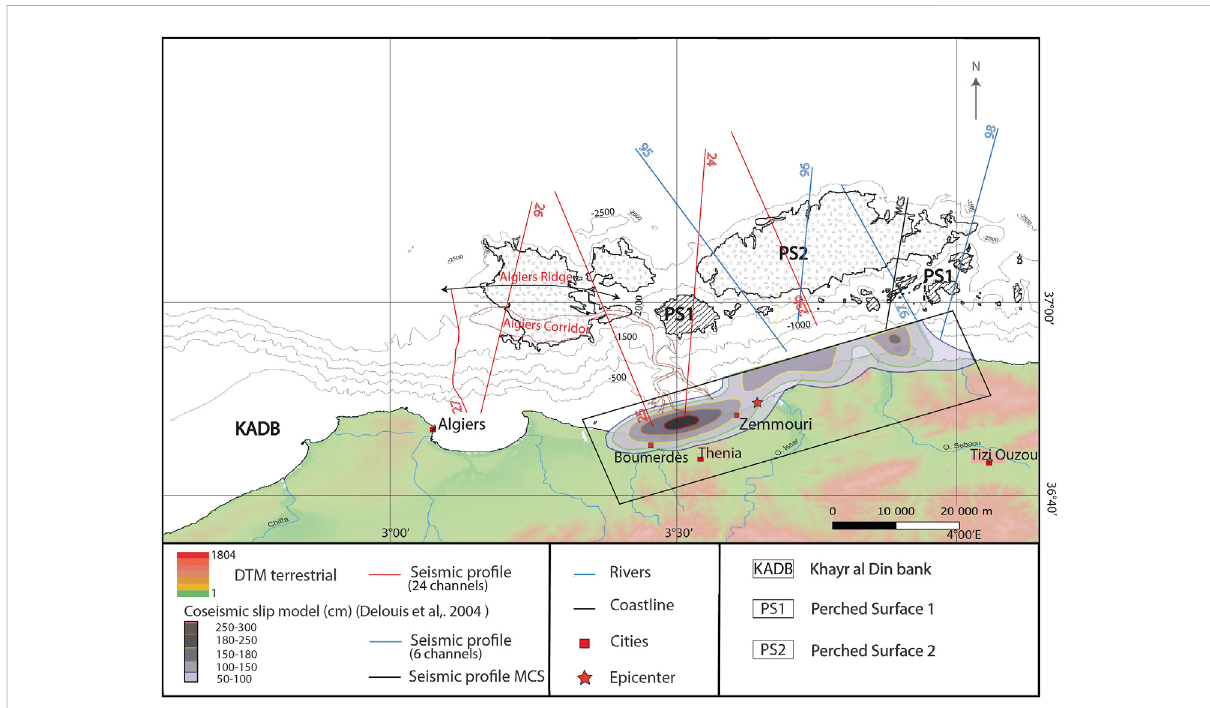
FIGURE 2 Map of the Boumerdès area displaying the position of the seismic sections used in this study and the contours of the two fl at surfaces PS1 and PS2 identi fi ed under GIS (see also Figure 3). Mean position of the 2003 May 21 rupture plane (projected in map view) is also shown as a thin black rectangle, after Delouis et al. (2004). This fault model makes the hypothesis of a single rupture plane ~60 km long and ~24 km wide extending from the surface to a depth of ~17 km. The grey contour lines inside the rupture plane displays the coseismic slip values in centimeters. Red dotted line locates the position of the Algiers canyon and corridor (Babonneau et al., 2017). MCS: Multichannel Seismic Section from the industry (Déverchère et al.,